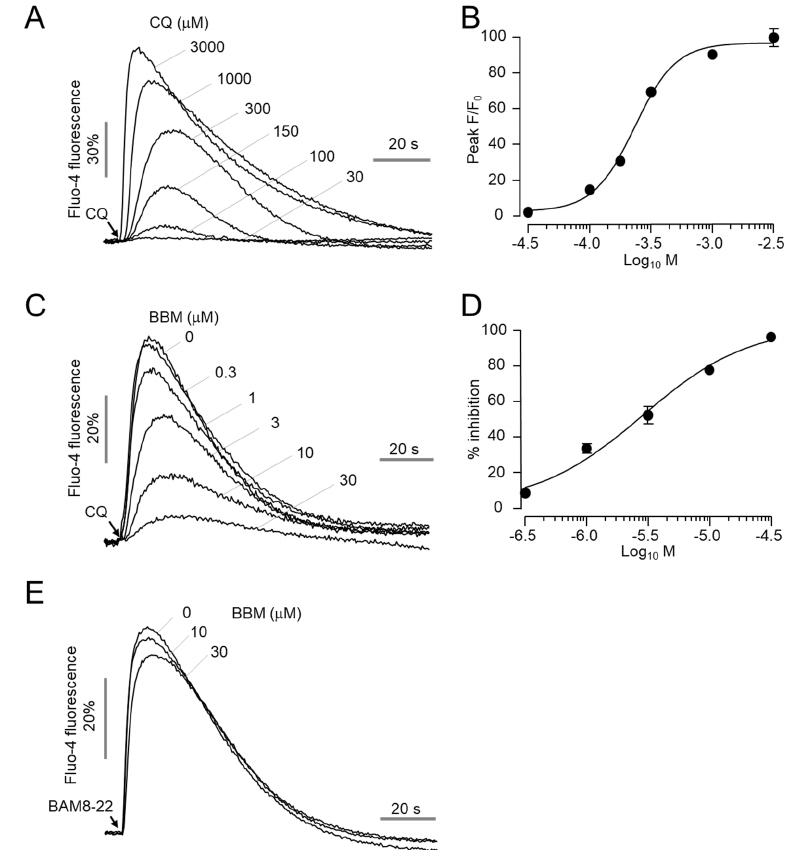
Figure 5. Effect of berbamine on CQ-induced activation of MrgprA3: ( A ) Intracellular calcium levels were measured in HEK293T cells expressing mouse MrgprA3. Cells were treated with indicated concentrations of CQ. ( B ) Summary of dose–response (mean ± S.E., n = 6). ( C ) Cells were pretreated with indicated concentrations of berbamine for 10 min prior to 300 μ M CQ treatment. ( D ) Summary of dose-response (mean ± S.E., n = 6). ( E ) Representative traces of intracellular calcium responses to BAM8 − 22 in HEK293T cells expressing MrgprC11. Cells were pretreated with the indicated concen- trations of berbamine for 10 min before treatment with 500 nM BAM8 − 22.